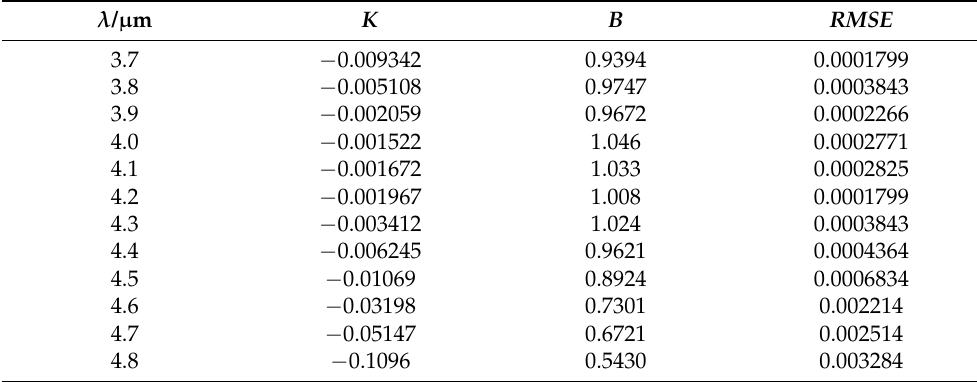
Table 1. Fitting coefficient of PWV and atmospheric transmittance.